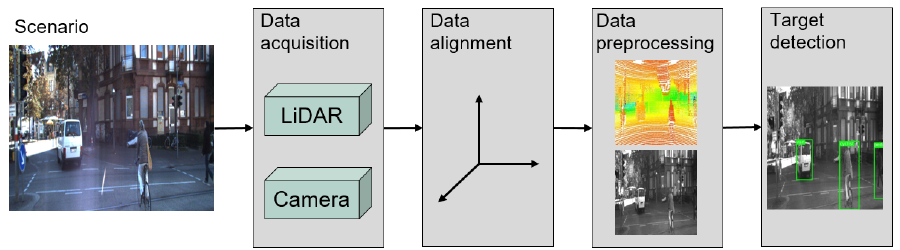
Figure 4. Full pipeline for target detection using our proposed model.